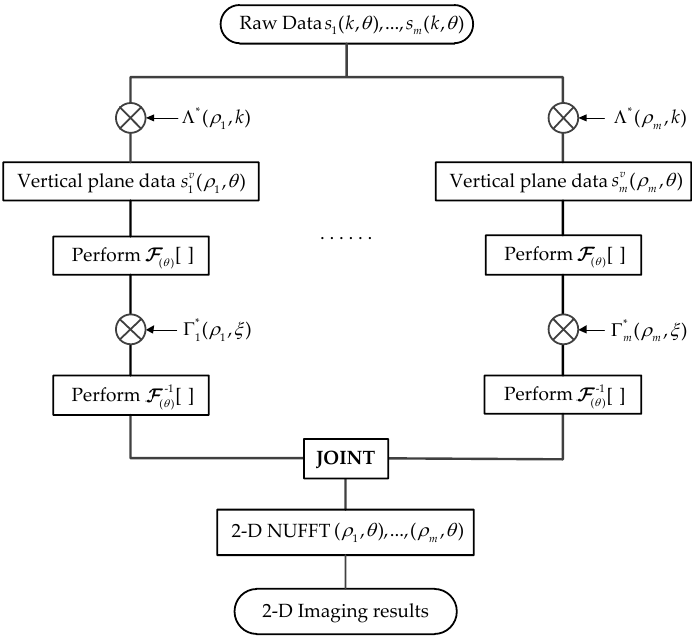
Figure 3 . Flowchart of the proposed imaging algorithm. Figure 3. Flowchart of the proposed imaging